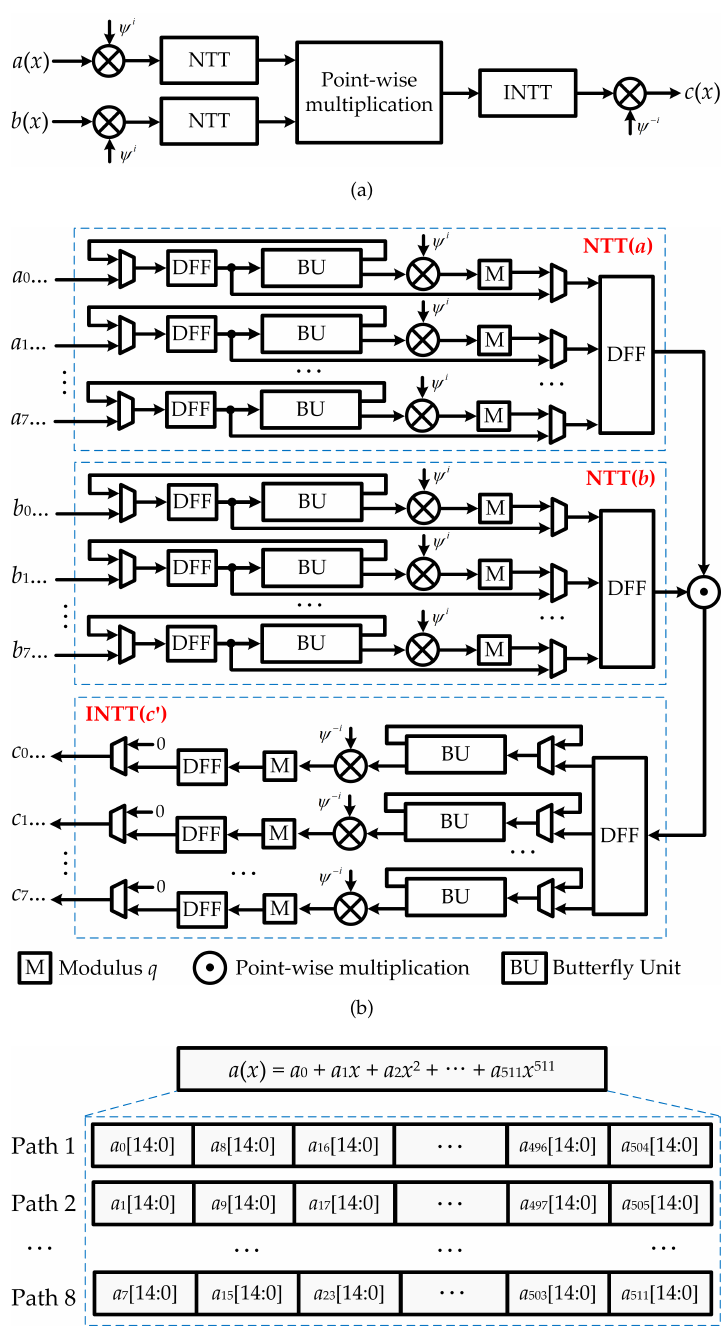
Figure 5. ( a ) Data flow of the proposed number theoretic transform (NTT) multiplier, ( b ) Proposed radix-8 multiple delay feedback (MDF)-architecture based NTT multiplier, and ( c ) Data structure of the proposed radix-8 MDF-architecture based